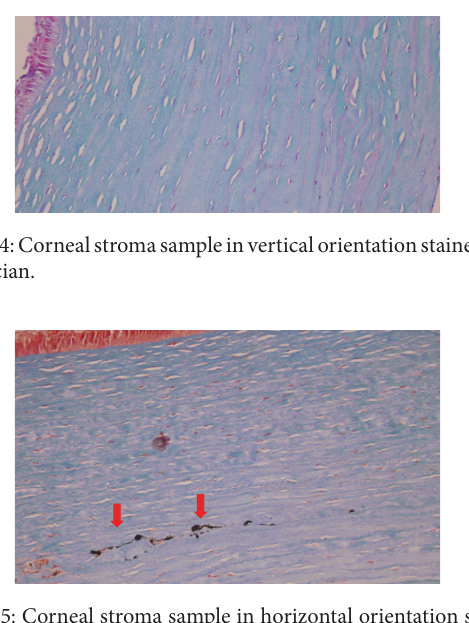
Figure 5: Corneal stroma sample in horizontal orientation stained with Masson trichrome. Solid red arrows showing the CNTs within the corneal tissue.